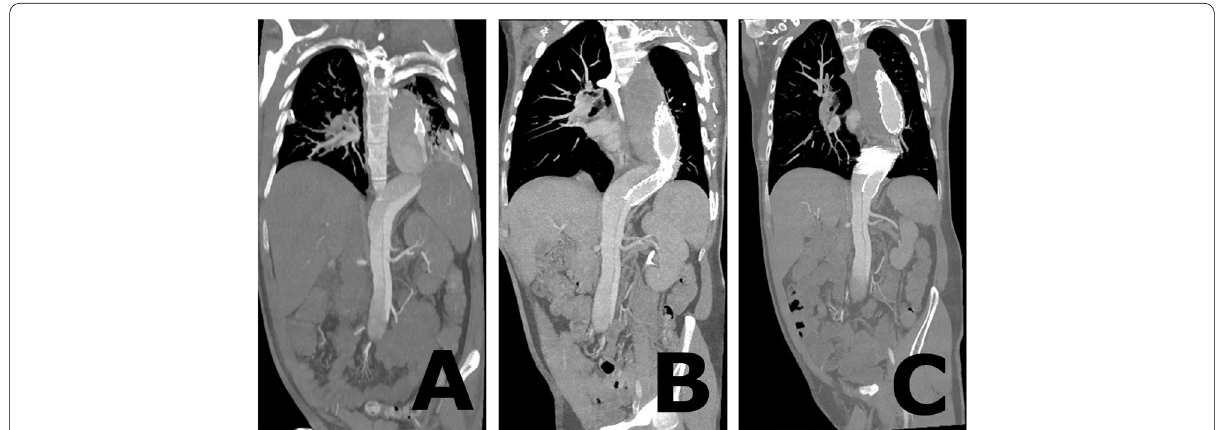
Fig. 4 A Coronal CT image before extension TEVAR showing filling of the FL. B Coronal CT image after extension TEVAR showing continuous filling of the FL. C Coronal CT image after extension TEVAR and CP procedure showing significantly reduced filling of the